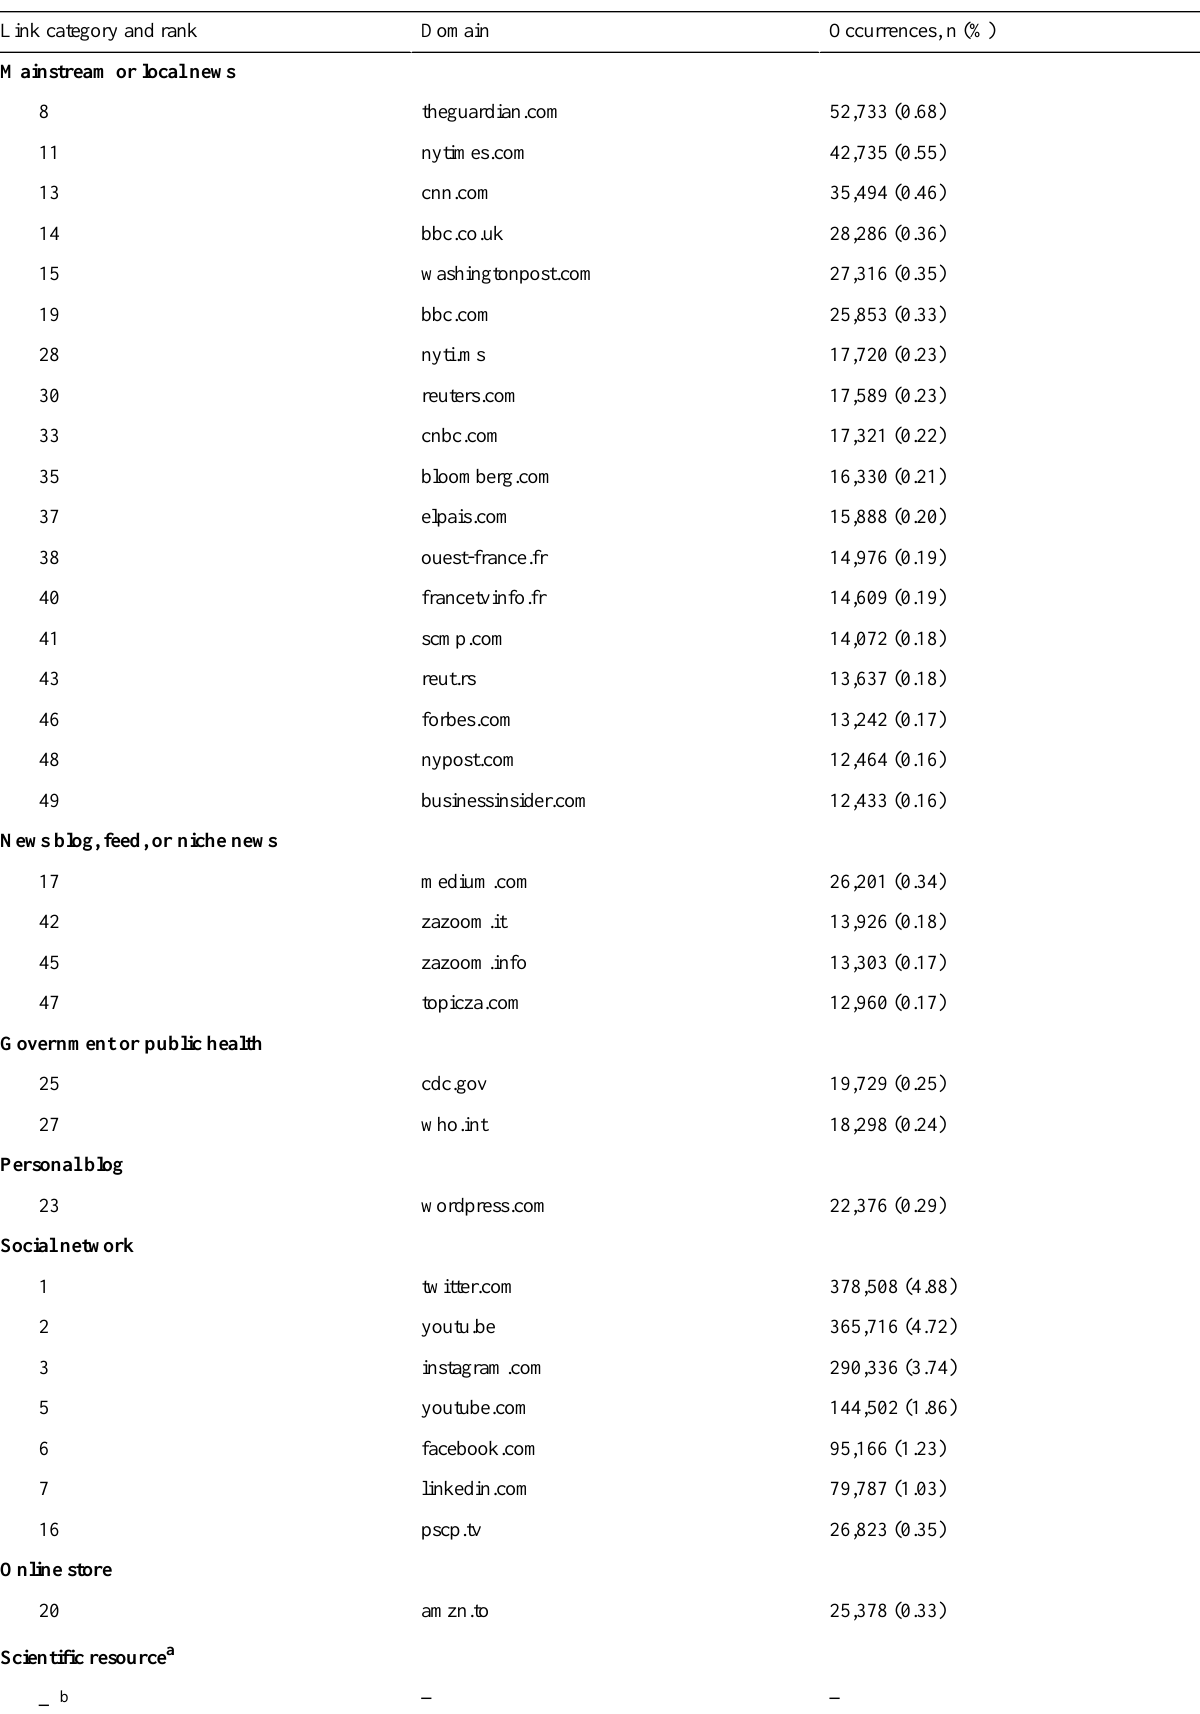
Table 3. Categorized top 50 shared website domains. Total number of occurrences of external references (n=7,753,841).